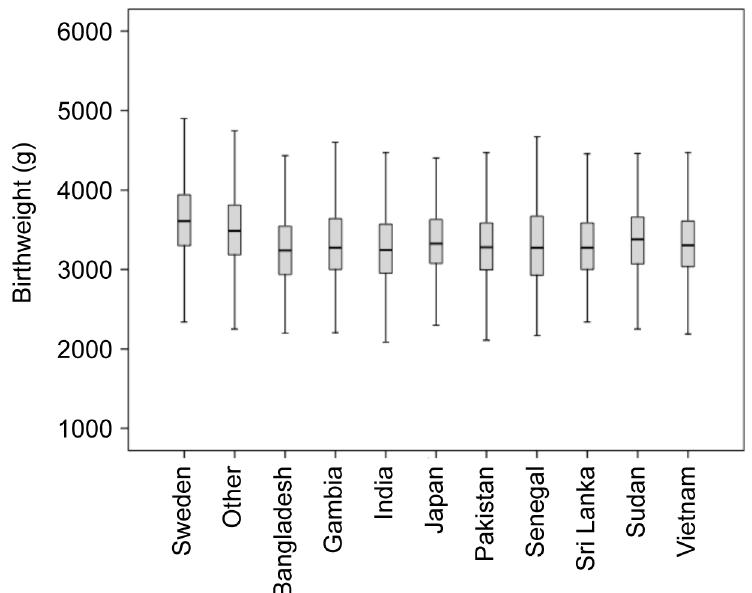
Fig 3. Unadjusted offspring birthweight distributions. Box and whisker plots for mothers born in Sweden (n = 647,953), Bangladesh (n = 905), Gambia (n = 713), India (n = 2636), Japan (n = 503), Pakistan (n = 1273), Senegal (n = 100), Sri Lanka (n = 1357), Sudan (n = 324), and in all other countries (n = 153,219). There is an overlap in distributions corresponding to a low